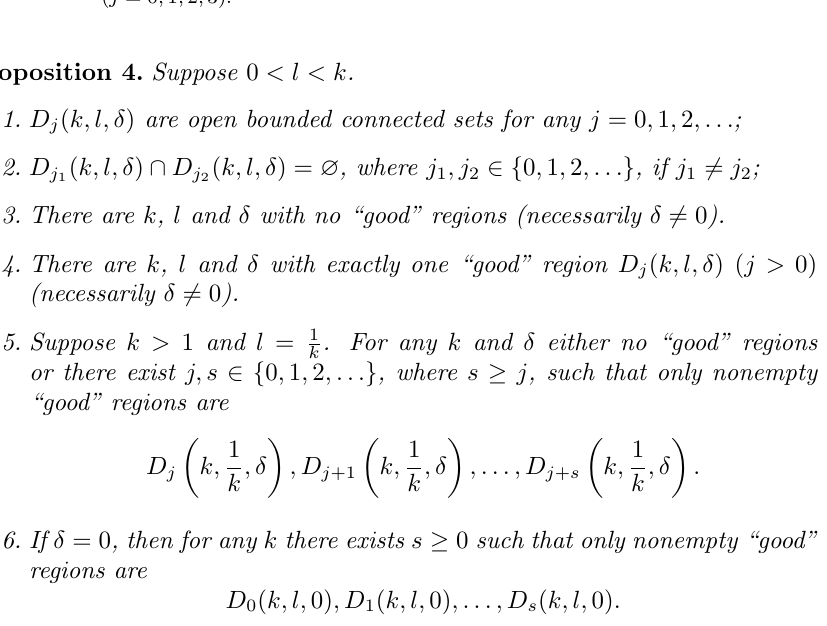
Figure 8. Boundary curves Ω j ( k, 1 of the regions which guarantee that the regions D j ( k, 1 ,δ ) are nonempty k ( j = 0 , 1 , 2 , 3).